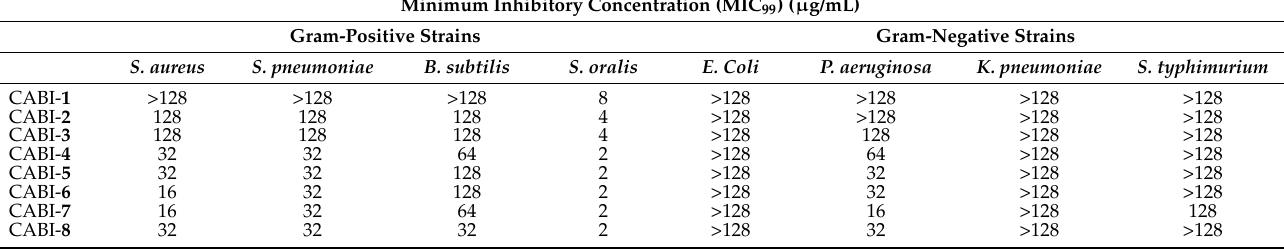
Table 1. Antibacterial properties of synthesized amphiphiles against different Gram-positive and Gram-negative